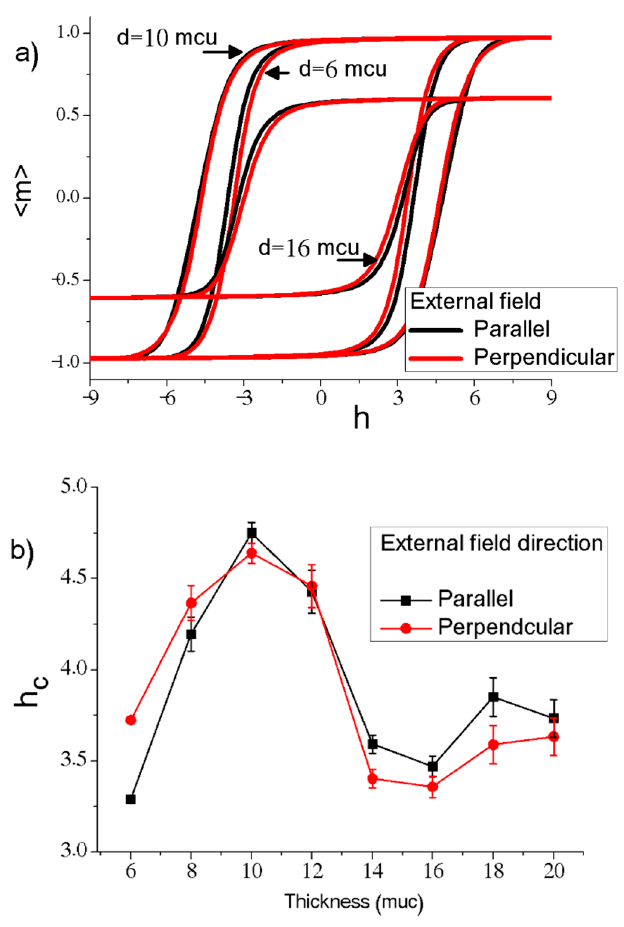
Figure 9. ( a ) Hysteresis loop at different thicknesses, and ( b ) a coercive field as a function of thickness for two different orientations of the external magnetic field.